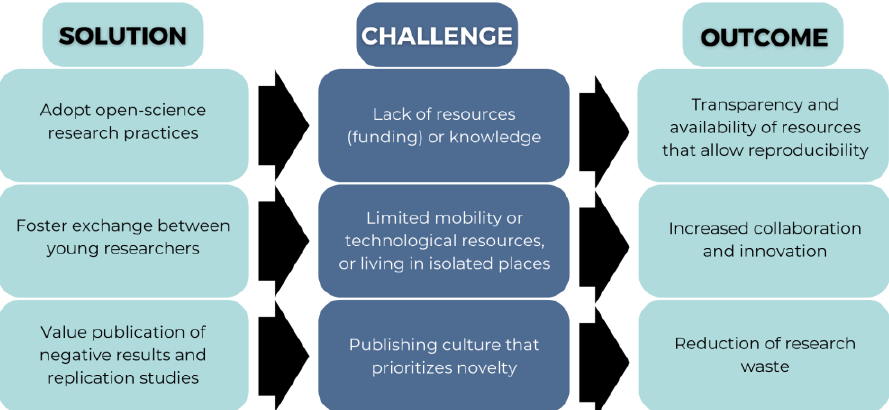
Figure 3. Examples of challenges to expect when implementing approaches aimed at improving reproducibility.